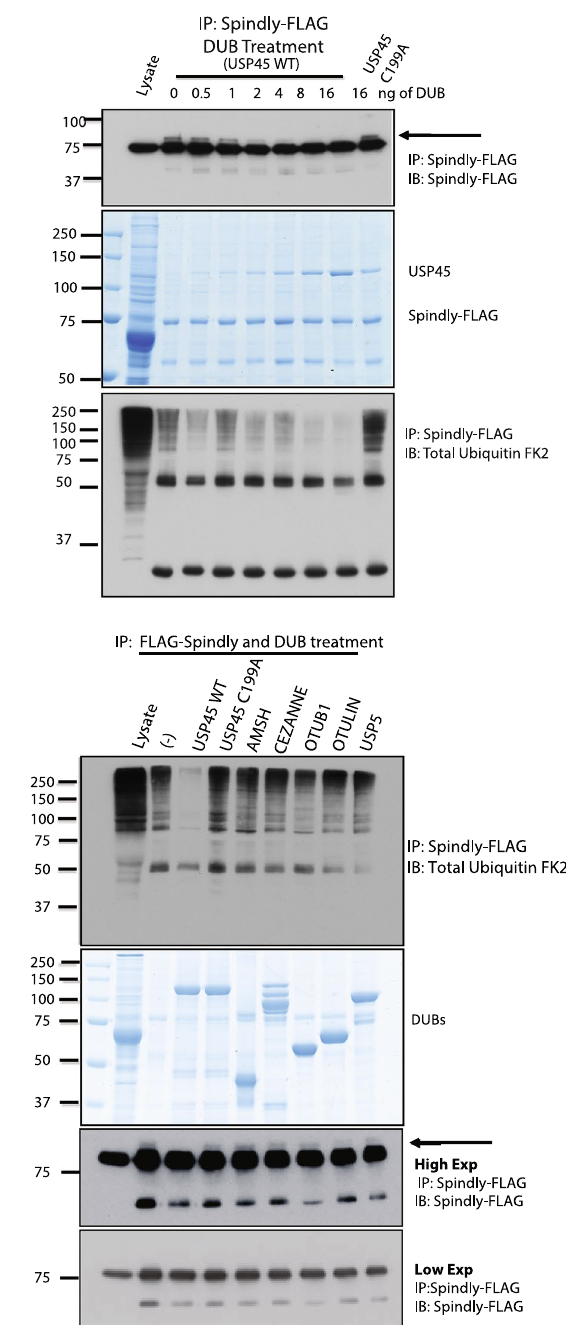
Figure 4. USP45 is a DUB that catalyses the di-monoubiquitylation of Spindly. ( A ) HEK293 cells were transfected with Spindly-FLAG. Spindly-FLAG was immunoprecipitated and treated in the absence or presence of increasing concentration of recombinant USP45 wild-type (WT) or catalytic inactive USP45 (C199A) at highest concentration. The immunoprecipitates were resolved on a polyacrylamide gel and subjected to immunoblotting with the indicated antibodies (upper and lower panels) or stained with Coomassie (middle panel). ( B ) HEK293 cells were transfected with Spindly-FLAG. Spindly-FLAG was immunoprecipitated and treated with several different DUBs. The immunoprecipitates were resolved on a polyacrylamide gel and subjected to immunoblotting with the indicated antibodies (upper and lower panel) or stained with Coomassie (middle panel). ( A , B ) All experiments were performed at least three times and a representative example is